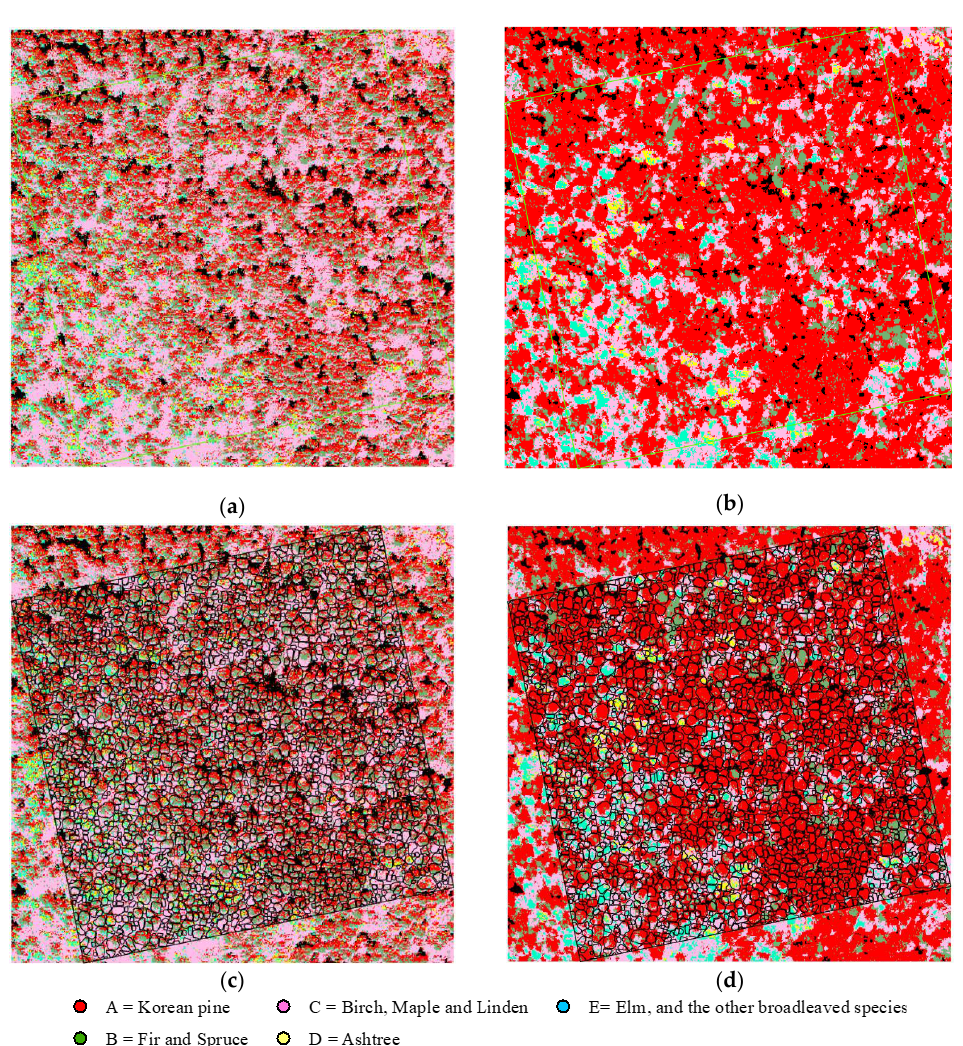
Figure 9. Classification results of the original hyperspectral image: ( a ) SAM classification results; ( b ) SVM classification results; ( c ) SAM classification results with individual tree segmentation; ( d ) SVM classification results with individual tree segmentation.